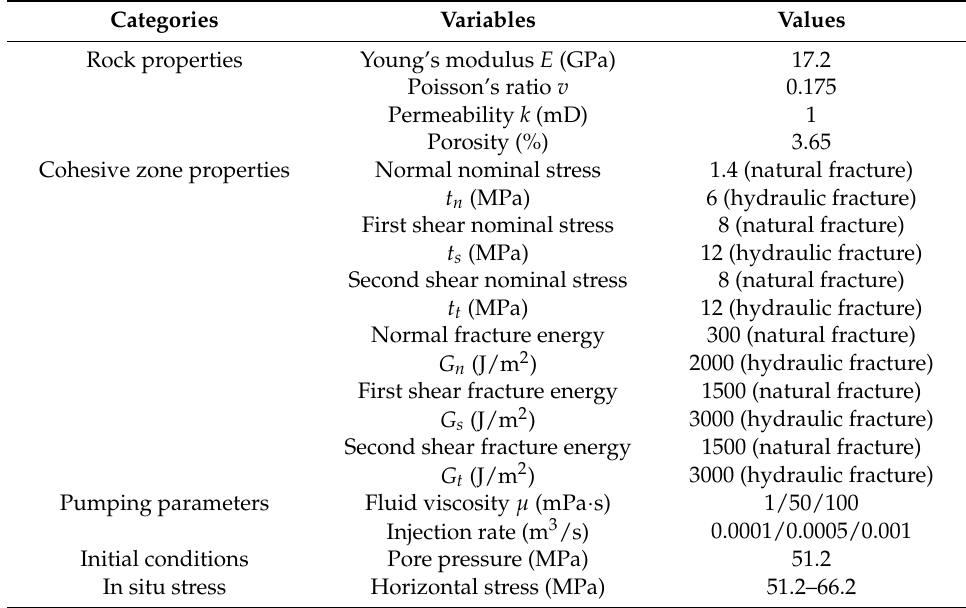
Table 1. Input variations of the numerical